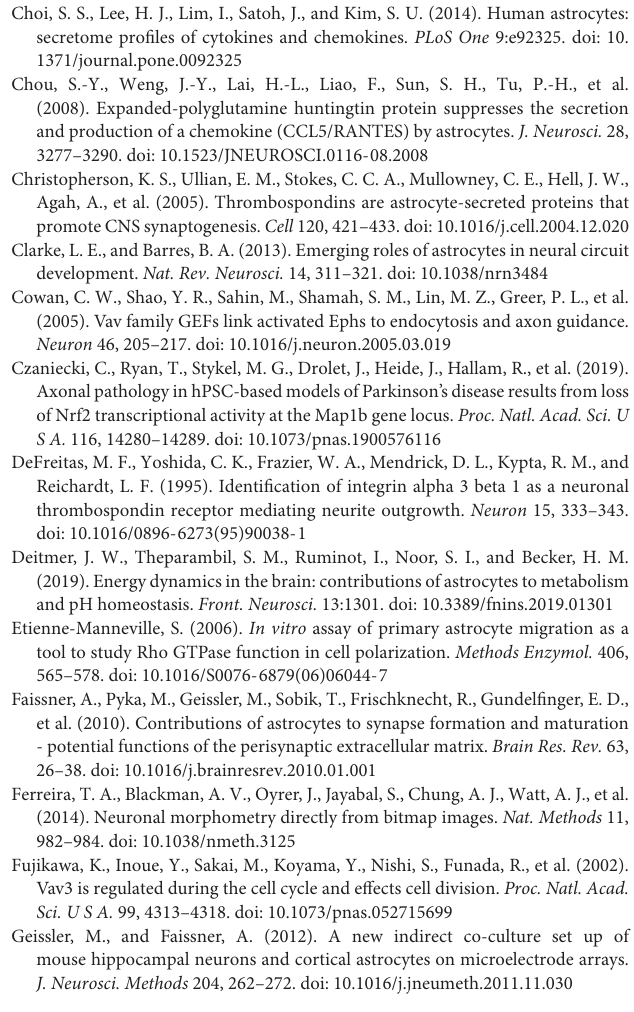
Supplementary Figure 1 | (A) ELISA standard curve for the determination of NT3 in the supernatant of wildtype and Vav3 − / − astrocytes after a conditioning time of 24 h. (B) The mean OD 450 values of the analyzed wildtype and knockout probes revealed exceedingly low levels of NT3 in the supernatants which, furthermore, did not differ between both analyzed